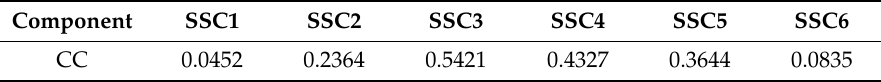
Figure 13. Results of performing the improved MEDA algorithm. Table 2. The correlation coefficient values of each component.